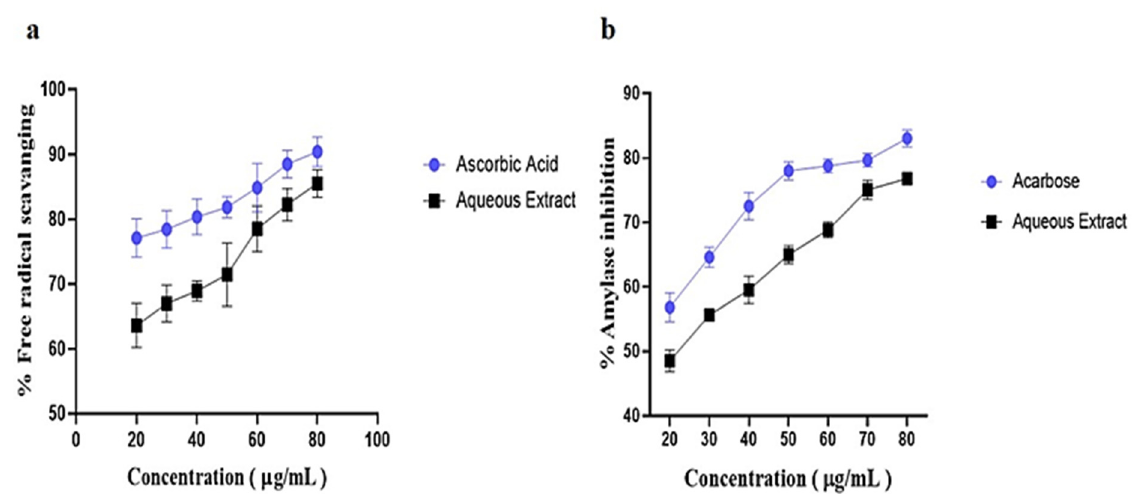
Figure 2. Antioxidant and alpha amylase inhibition activity. ( a ) The free radical scavenging activity of aqueous extract increased with the increasing concentration of the extract showing its inhibitory potential for free radicals. ( b ) The potential of aqueous extract to inhibit alpha amylase increased with the increasing concentration of the extract showing that it can manage postprandial hyperglycemia. Table 1. Phytochemical screening of aqueous extract of Thymus serpyllum.